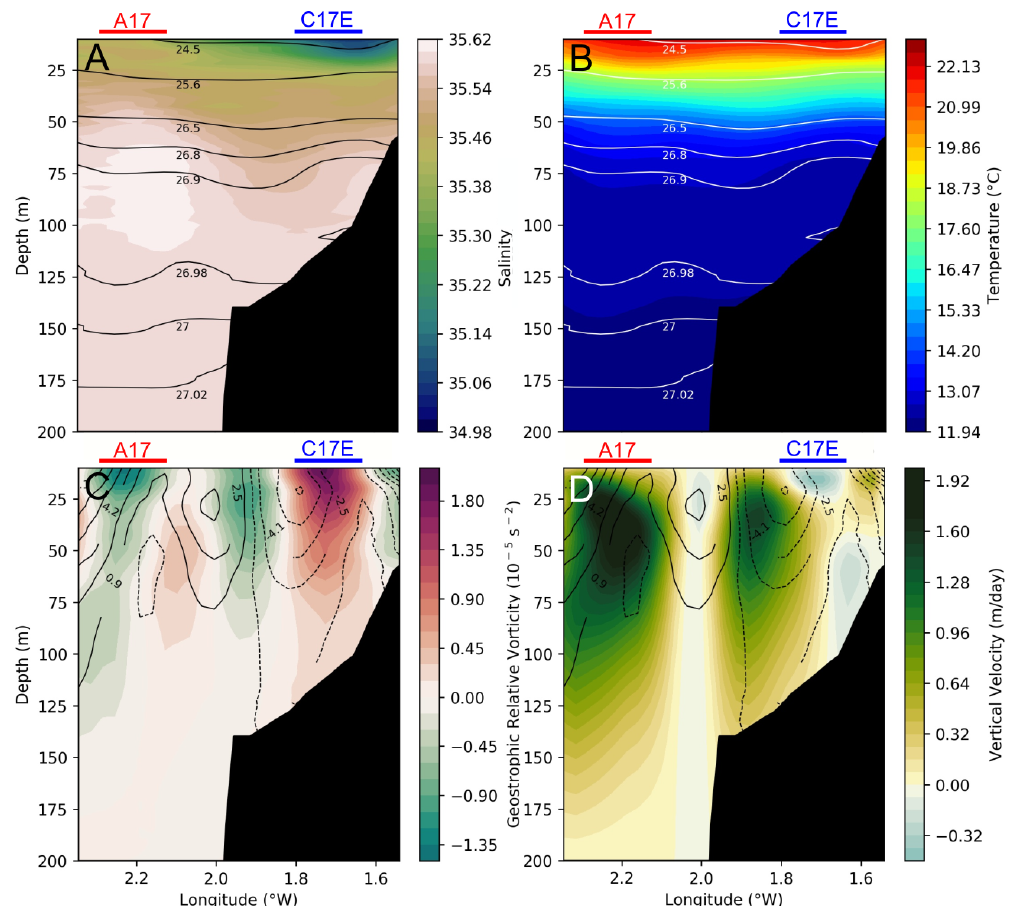
Figure 5. Cross section at 43.77 ◦ N (location marked by dashed lines in Figs. 1 and 4), representing salinity (a) and temperature (b) with isopycnals (black and white contours, respectively) and vorticity (c) and vertical velocities (d) with meridional geostrophic velocities (solid (dashed) black contours for positive (negative) velocities) for the period (2 to 4 August 2017). Negative vorticity values represents an- ticyclonic circulation, while positive values represent cyclonic circulation. Positive (negative) values for geostrophic velocity represent a northward (southward) current. Negative (positive) vertical velocity values represent downwelling (upwelling). The red (blue) horizontal lines represent the horizontal extension of A17 (C17E) that the section